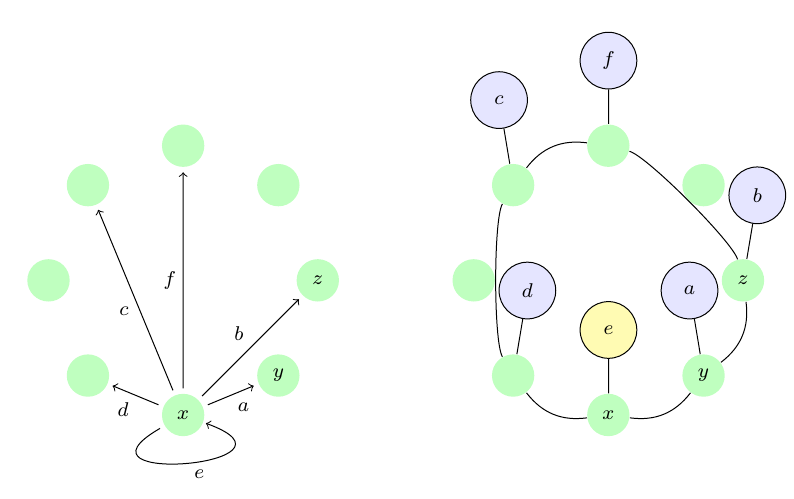
Fig. 3. Let G = { a,b,c,d,e,f } with e being the identity, and X = { x,y,z,... } . If a group action, shown on the left, maps a point x ∈ X to distinct reachable points, each reachable point corresponds to only one element in G . These reachable points can be joined together by arcs, shown on the right, giving the orbit x . The “balloon” over each y ∈ orbit x contains the group element which acts on x to reach y . Note the balloon over x is stabilizer x , in this case just { e } , corresponds to the self-loop over x on the left.